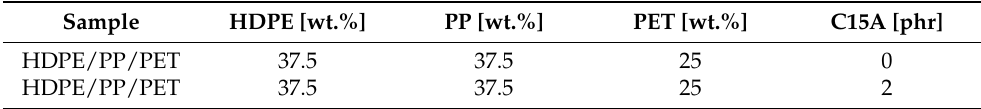
Table 1. Samples